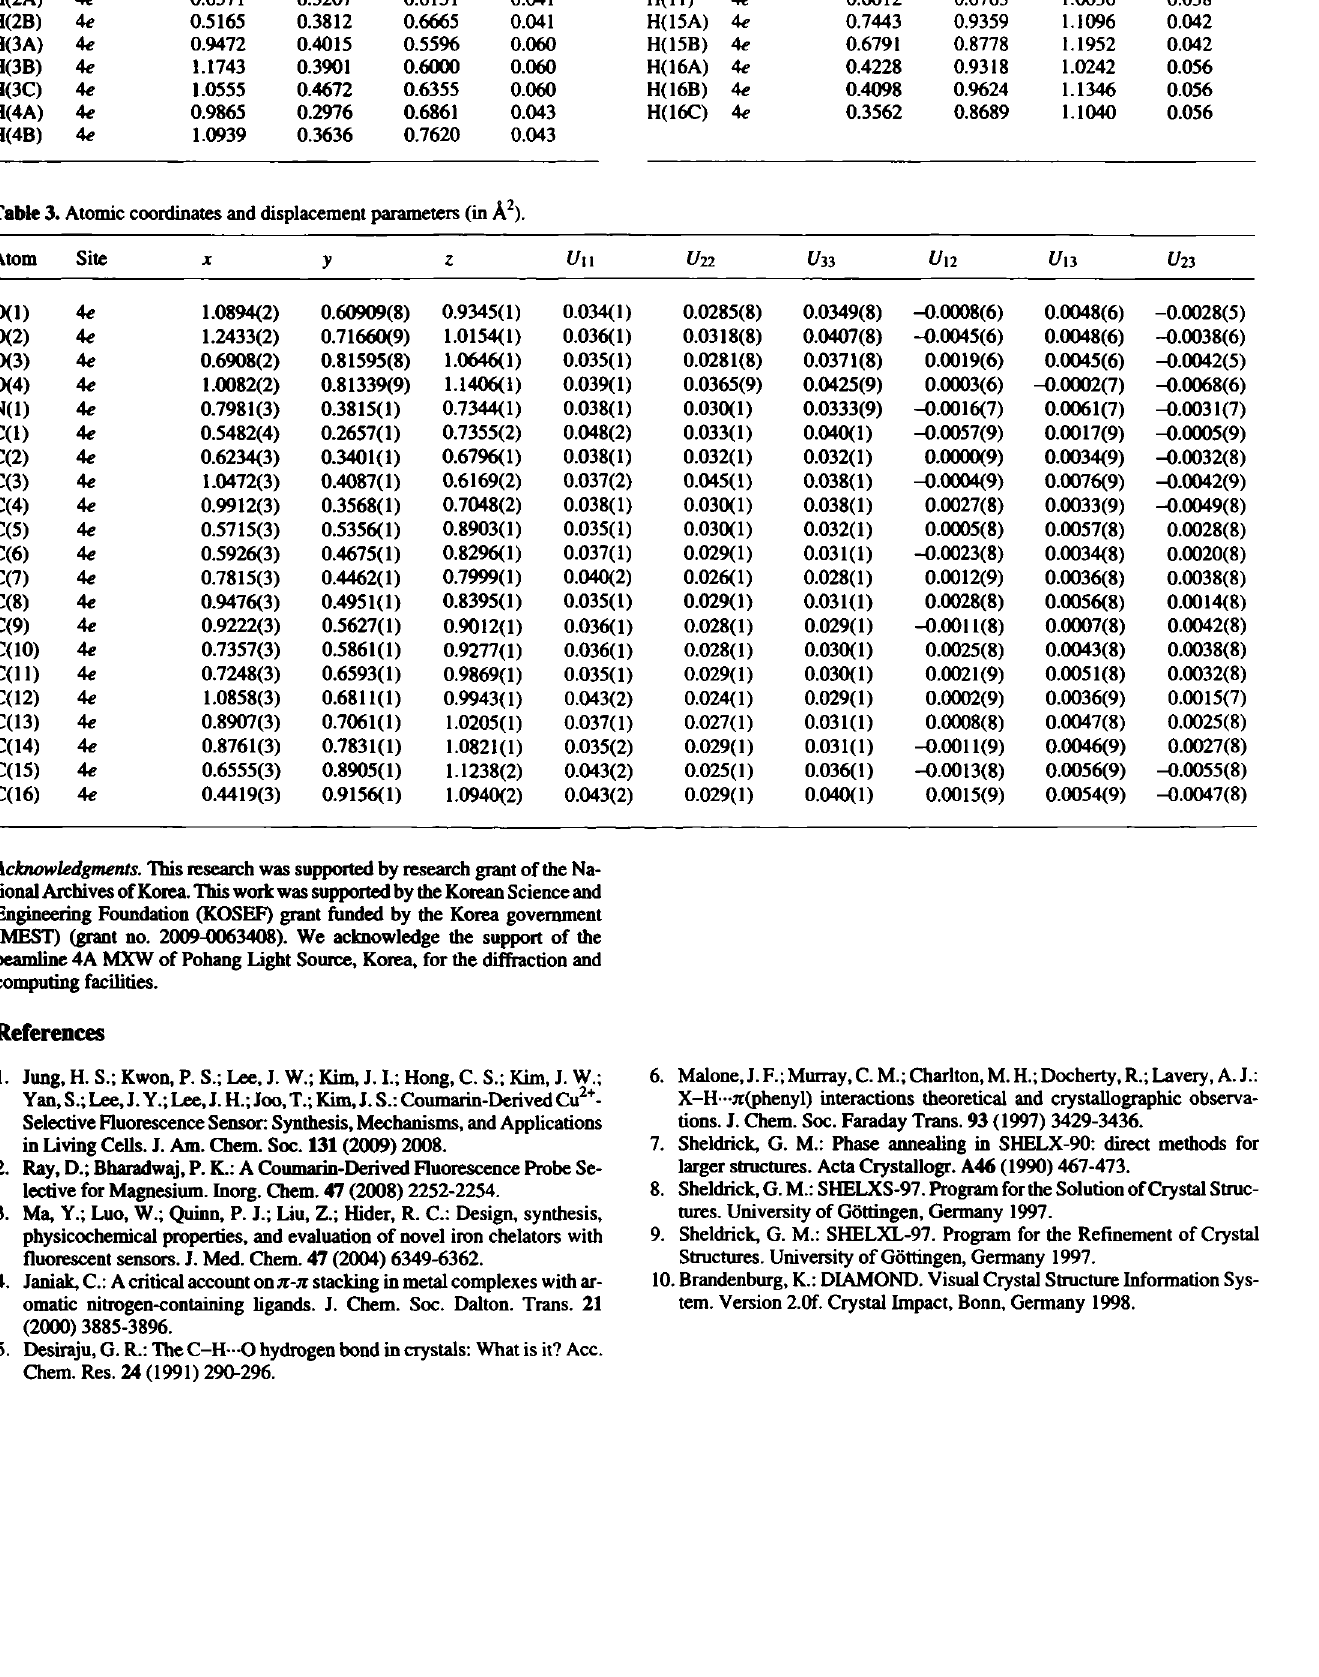
Table 3. Atomic coordinates and displacement parameters (in Â 2